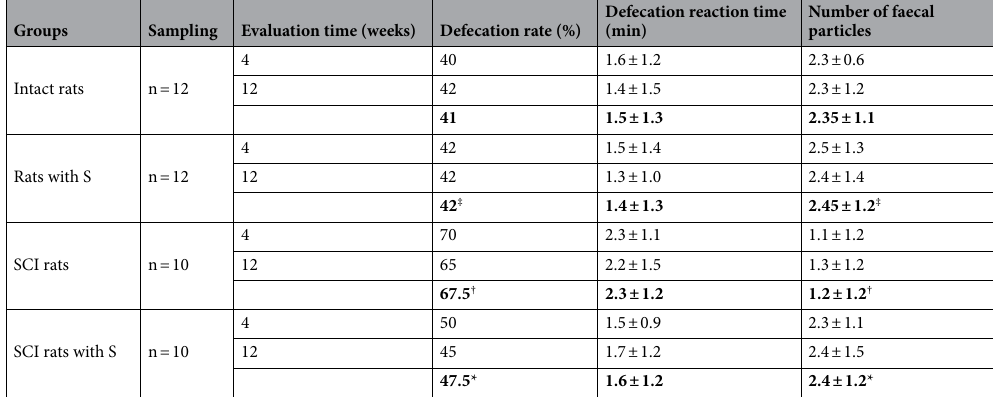
Table 2. Response of defecation induced by manual defecation stimulation. Defecation reaction time, the time from the beginning of the massage stimulation to that the first faecal particle was excreted. Bold type, the average of the two time points. *p < 0.05, comparison between SCI Rats with S and SCI Rats; † p < 0.05, between SCI Rats and Intact Rats; ‡ p < 0.05, between Rats with S and SCI Rats (Chi-square test or two-way ANOVA).